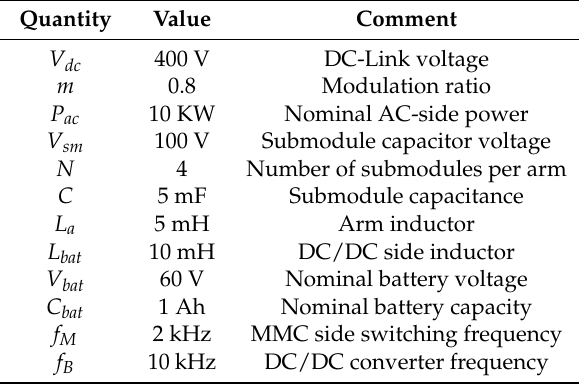
Table 1. Parameters of simulation